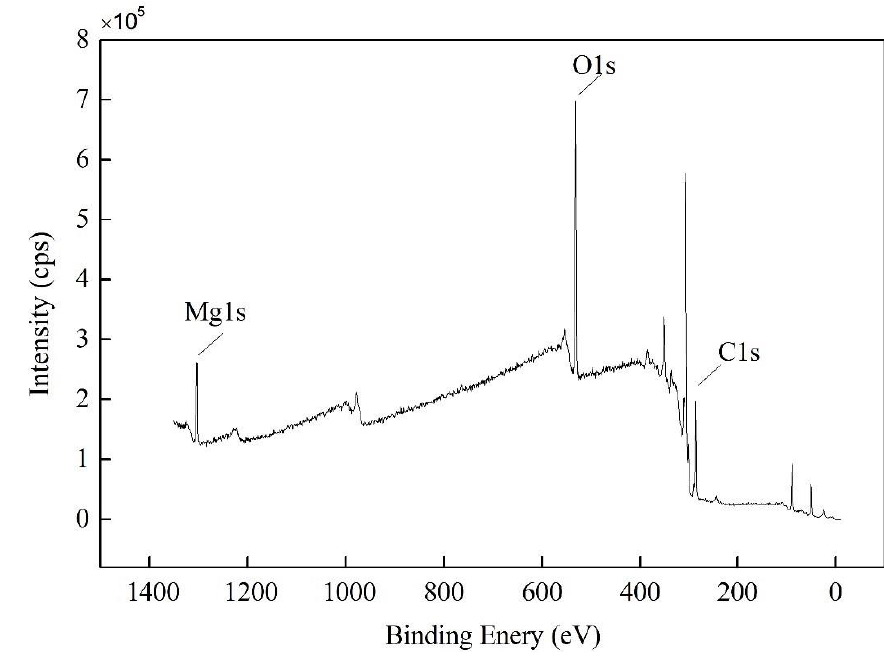
Figure 3. XPS spectrum of Mg microparticles.